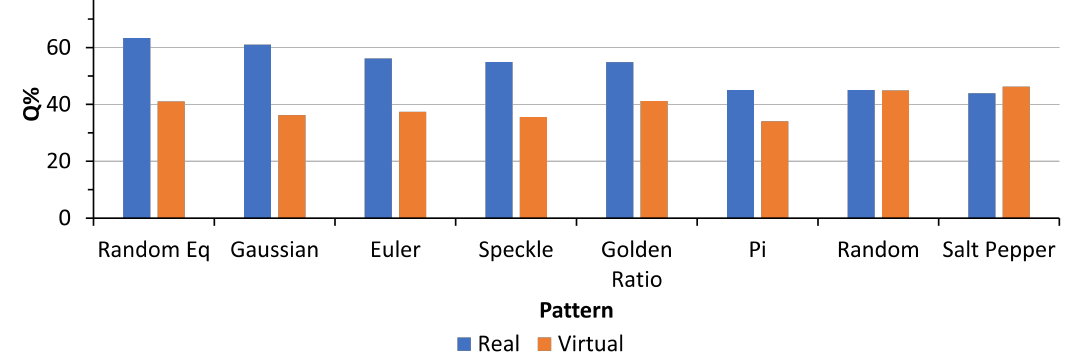
Figure 7. The quality score graph of the point clouds from phase one real and virtual experiments.